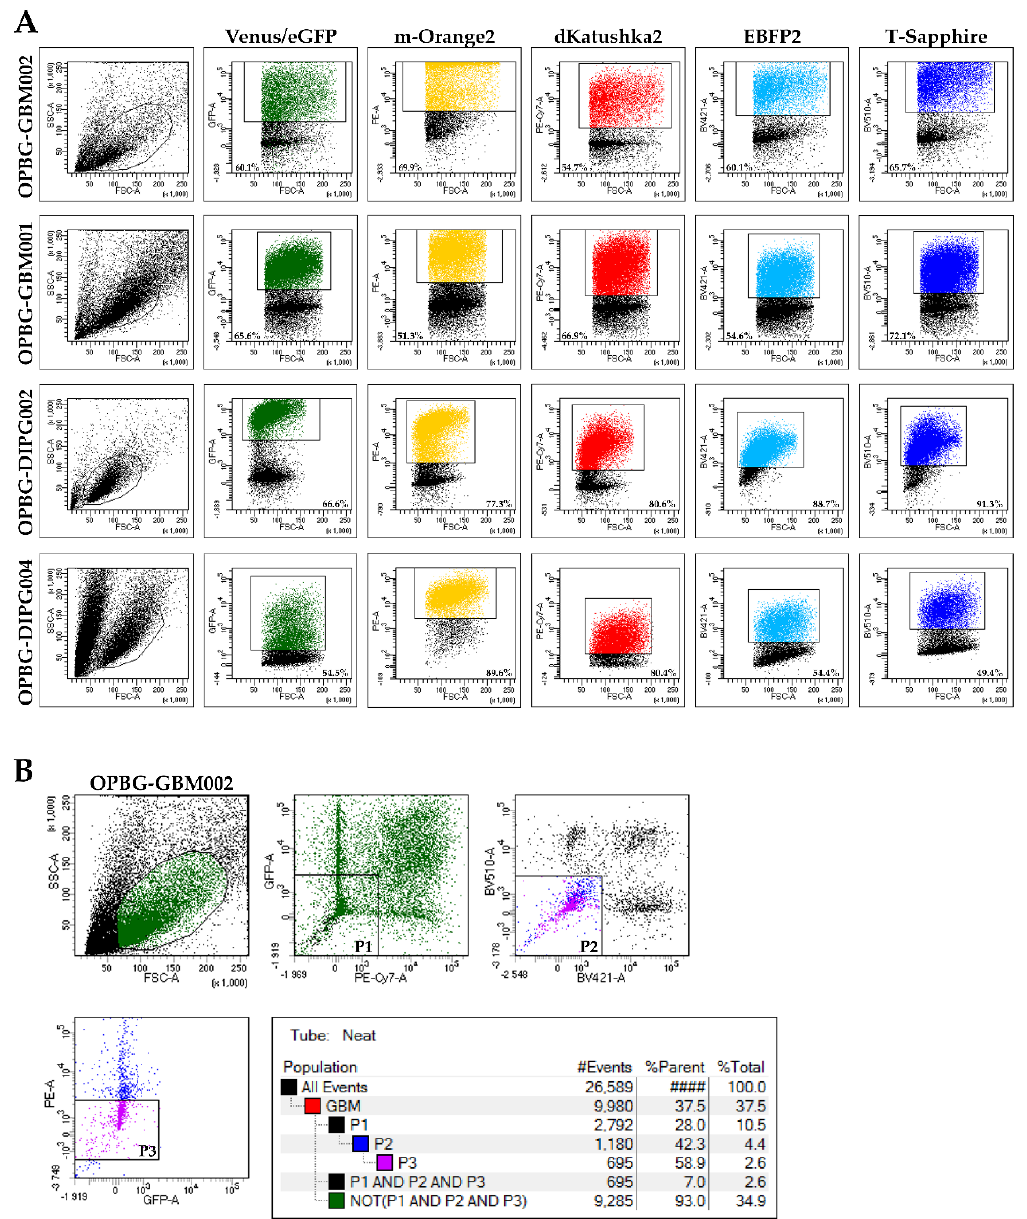
Figure 2. Flow cytometry and FACS analysis of the pGBM and DIPG multifluorescent primary cell lines. ( A ) The pGBM and DIPG multifluorescent cell lines flow cytometry analysis shows the differential transduction efficiency of four instead of six fluorescent LeGO vectors. The six different fluorescences were analyzed with different emission detection range GFP ‐ 530/30 (eGFP), GFP ‐ 545/35 (Venus), PE ‐ 582/15 (m ‐ Orange2), PE ‐ Cy7 ‐ 780/60 (dKatushka2), BV421 ‐ 450/40 (EBFP2) and BV510 ‐ 510/50 (T ‐ Sapphire). ( B ) FACS gating strategy example used to perform the single cell ‐ flow sorting of pGBM and DIPG multifluorescent bulk population. The FACS analysis was performed using a flow cytometer with cell ‐ sorting capability (BD FacsAria TM III). The exemplified experiment is relative to OPBG ‐ GBM002 multifluorescent bulk cell line.